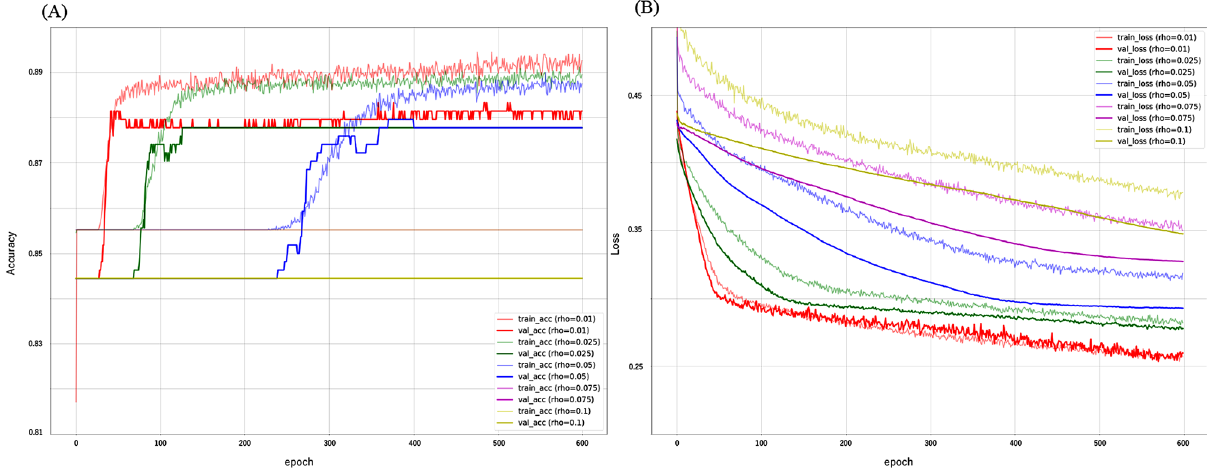
Figure 1. Learning curve by grid search for SAM ρ determination. ( A ) accuracy score ( B ) loss scoreIn Epoch300, the convergence was good when ρ was 0.01 or 0.025. In the comparison of ρ = 0.025 and 0.01 in Loss, 0.025 was more